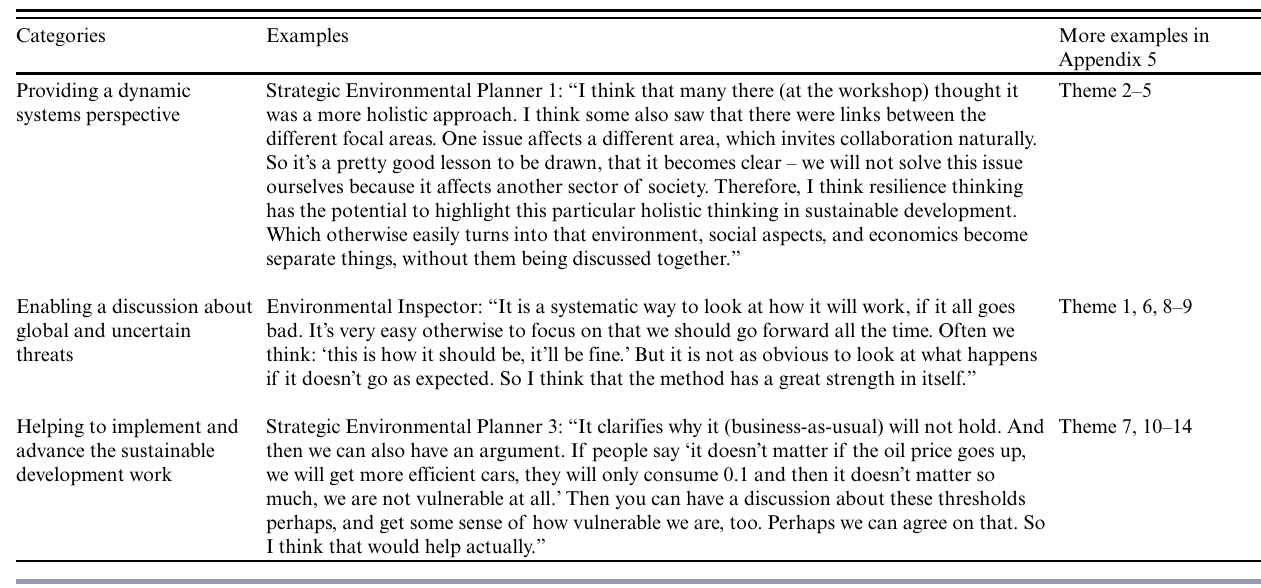
Table 1 . Examples of the three main ways the participants considered the resilience assessment to contribute to existing planning at Eskilstuna municipality. The categories are based on a clustering of the themes in Appendix 5. Quotes are translated from Swedish by My